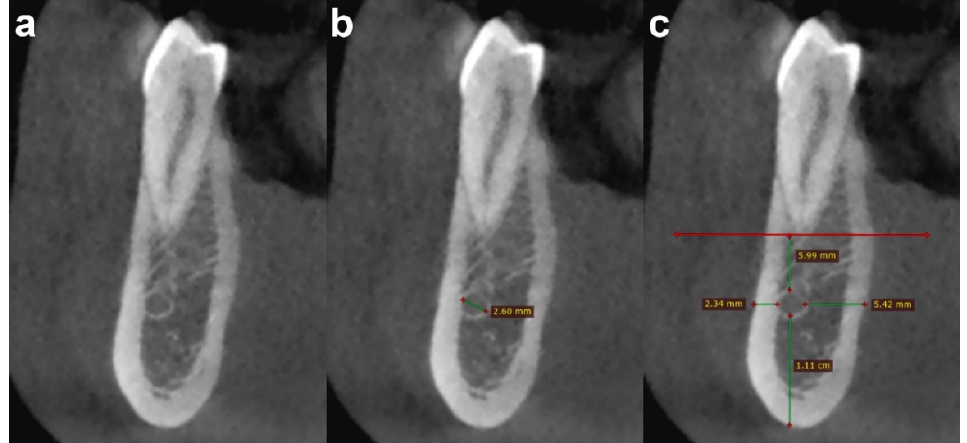
Figure 3. Cross-sectional CBCT images show an example of the steps of image analysis of the MIC at the first premolar level, as follows: ( a ) detection; ( b ) diameter measurement; and ( c ) distance measurement from adjacent anatomical landmarks (cortical plates and first premolar apex).